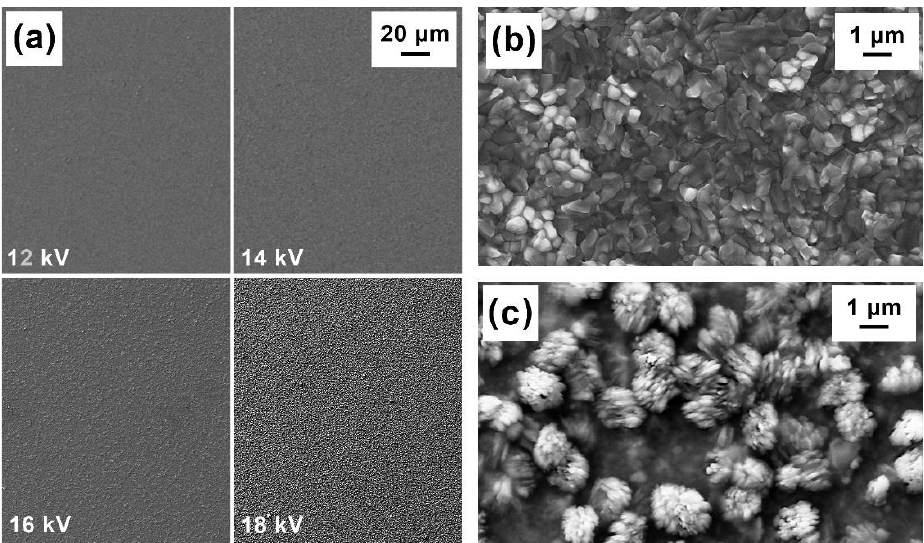
Figure 3. SEM images of Cu-doped Sb 2 Se 3 thin films deposited by LT-PED on Mo substrate: ( a ) a surface roughness comparison for samples deposited with different accelerating voltages; ( b ) a higher magnification of the sample deposited at 16 kV; and ( c ) a higher magnification of the sample surface deposited at 18 kV.